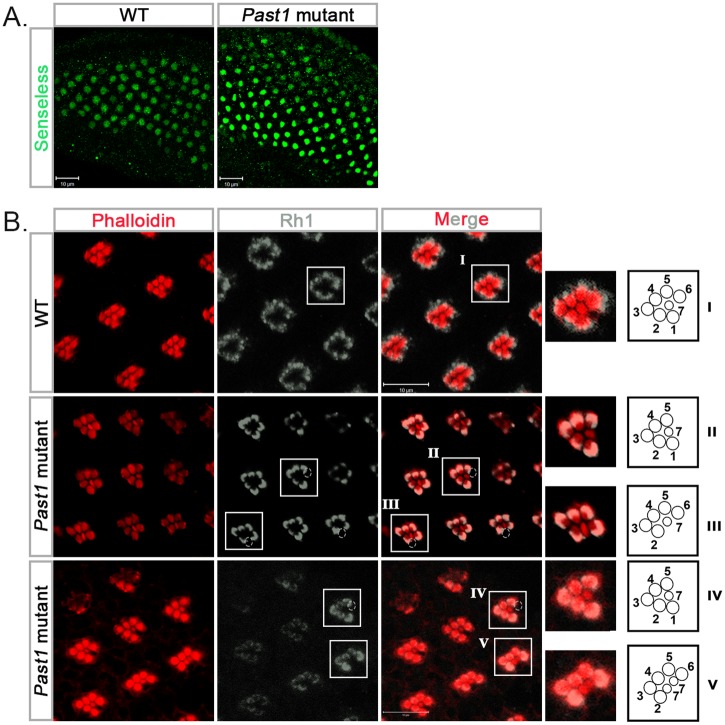
Photoreceptor differentiation in Past1 mutant fly eye.(A) Senseless staining of wild type and Past1110-1 homozygous mutant eye discs from third instar larvae. Shown are a Z-projections of confocal sections. (B) Phalloidin (red) and rhodopsin 1 (Rh1) (grey) staining of wild type Past1110-1 homozygous mutant late pupal eyes (85-96h after puparium formation). A schematic illustration depicting the localization of different photoreceptors in each zoomed-in image is shown on the right of each panel: I—ommatidium with normal seven photoreceptors (R1-R7), II—photoreceptor R6 is missing, III—photoreceptor R1 is missing, IV—photoreceptor R6 is missing, V—photoreceptor R1 is missing and there are two photoreceptors R7. The dotted circles outline the missing R1/R6 photoreceptors.